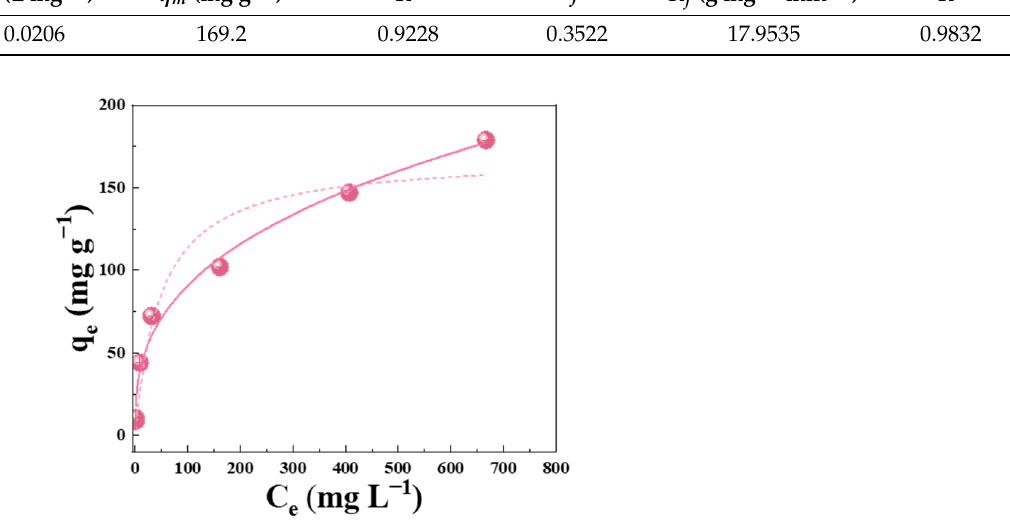
Figure 7. MB Adsorption isotherms fitted by Langmuir model (dashed line) and Freundlich model (solid line). Table 5. Comparison of adsorption performance of PV-Cu-BTC toward MB removal over other reported MOFs